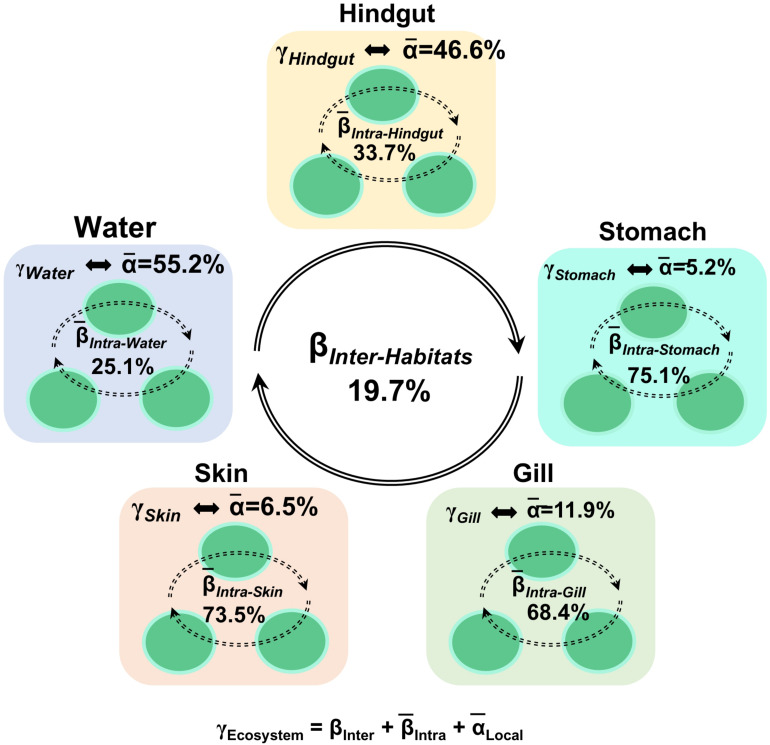
Multi-scales hierarchical partitioning of variant diversity. The total diversity at the ecosystem level (γEcosystem) was partitioned into the contribution of skin, gill, stomach, hindgut and water. We expressed this total compositional diversity within the ecosystem as the sum of inter-habitat compositional difference (βInter–Habitats), the mean intra-habitat compositional difference (¯βIntra–Habitats) and the mean local diversity (¯αLocal–Habitats) by γEcosystem = βInter–Habitats +(¯βIntra–Habitats) +(¯αLocal–Habitats).